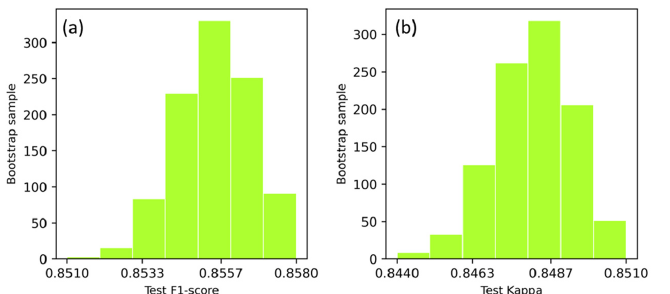
Figure 2. Distribution of test accuracies with 1000-run of bootstrap resampling for the classification of DSPE communities using F1-score ( a ) and Kappa coefficient ( b ).